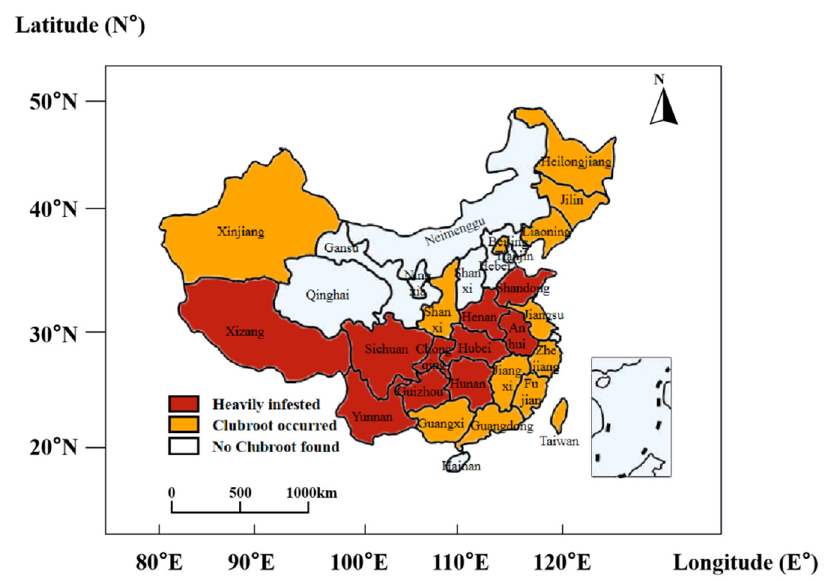
Figure 1. The distribution of clubroot disease in mainland China (Reprinted with permission from Ref. [Wang et al 2021]. 2021, Wang, Y.Y.; Yang, Z.Q.; Yang, Q.Y.; Zhang, C.Y.).